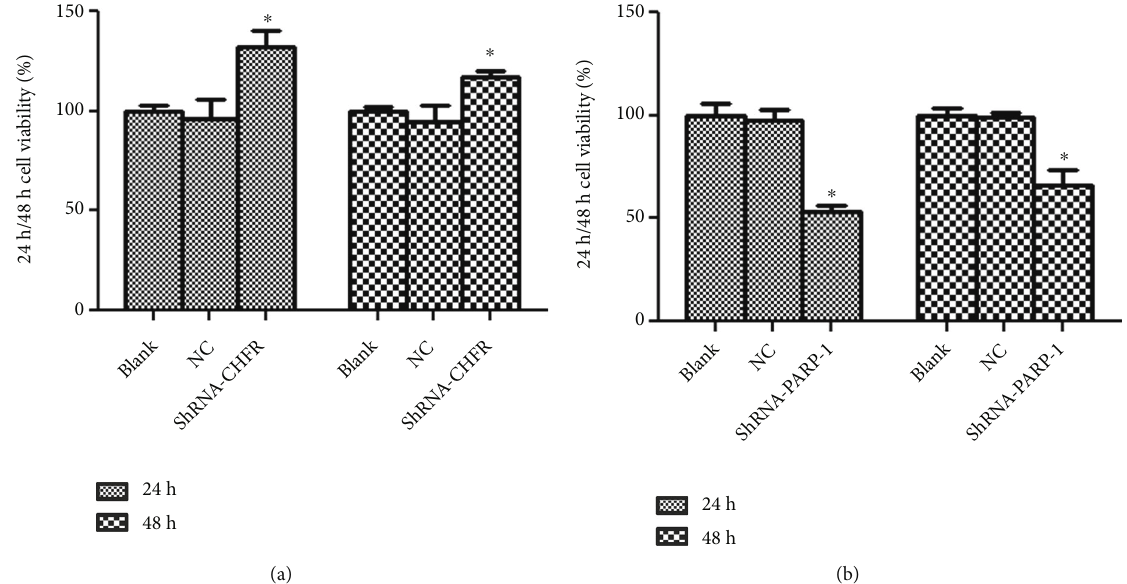
Figure 4: The e ff ects of CHFR and PARP-1 on the cell viability of Raji cells using cell counting kit-8. The relative cell viability of Raji cells after the cells ’ transfection with sh-CHFR (a) and sh-PARP-1 (b) lentivirus for 24 and 48 hours determined by cell counting kit-8. * P < 0 : 05 , compared with the blank